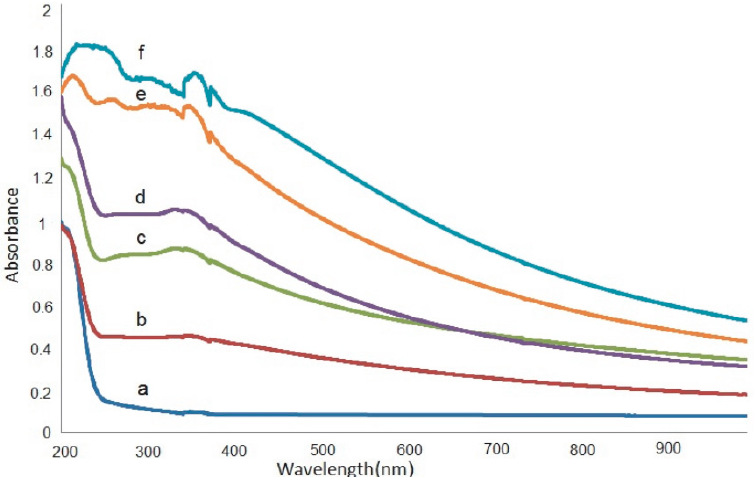
Figure 18. UV–visible absorption spectra for ( a ) pure PVA, ( b ) 1.5, ( c ) 2.5, ( d ) 5, ( e ) 7.5 ( f ) and 10 wt% TiO 2 [154].